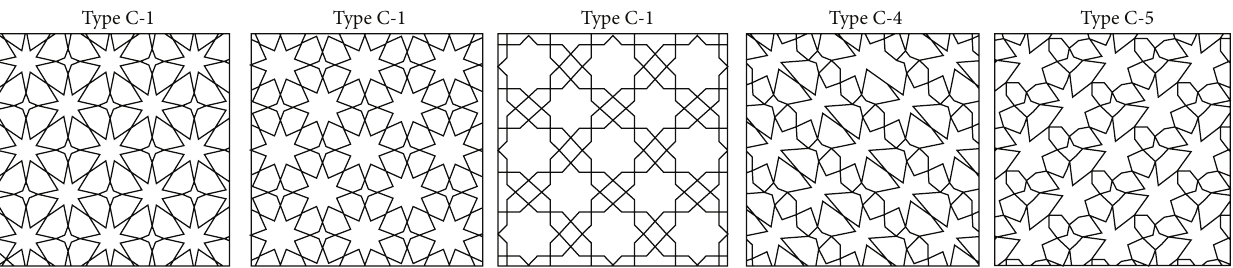
Figure 28: Type C